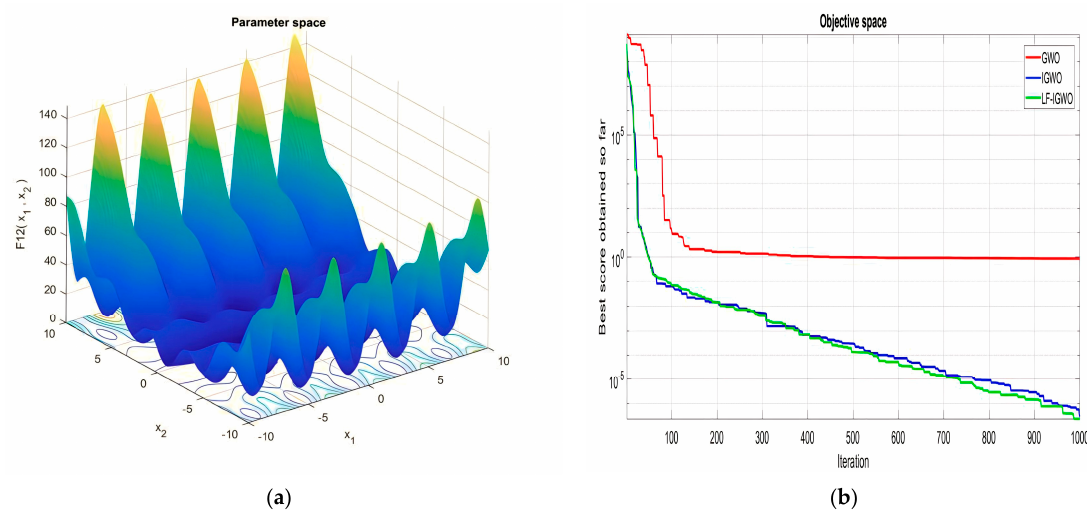
Figure 14. ( a ) Search space for multi model function F12 ( b ) Comparison of convergence curve for F12.